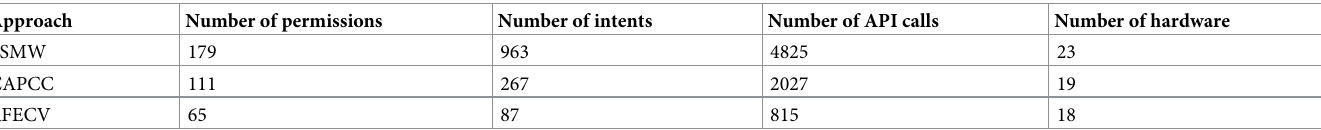
Table 12. The details of the features processed by three levels of feature selection methods.